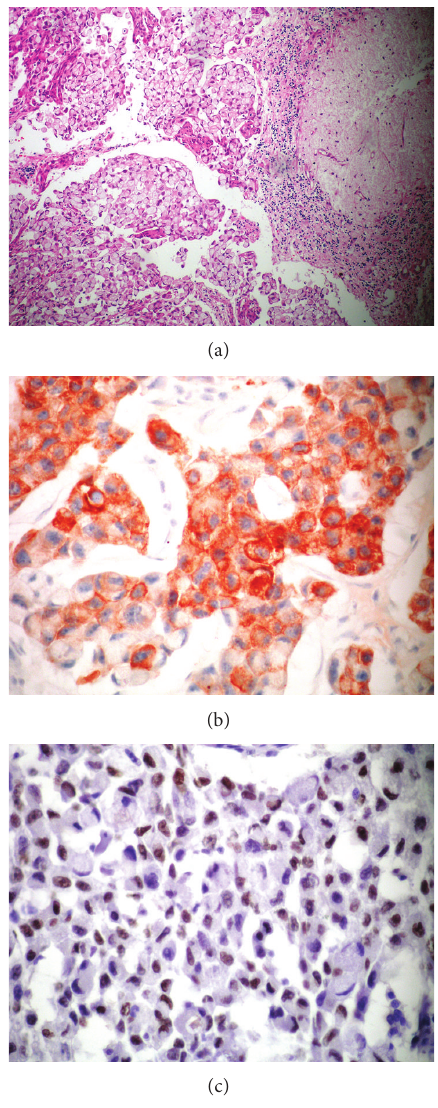
Figure 2: (a) Malign epithelial infiltration in the cerebellum with signet-ring cell morphology. HE x100. (b): Cell groups in the tumor show positive staining with cytoplasmic CK 7. CK7 x200. (c) Positive nuclear staining with TTF-1 in the signet-ring tumor cells. TTF-1